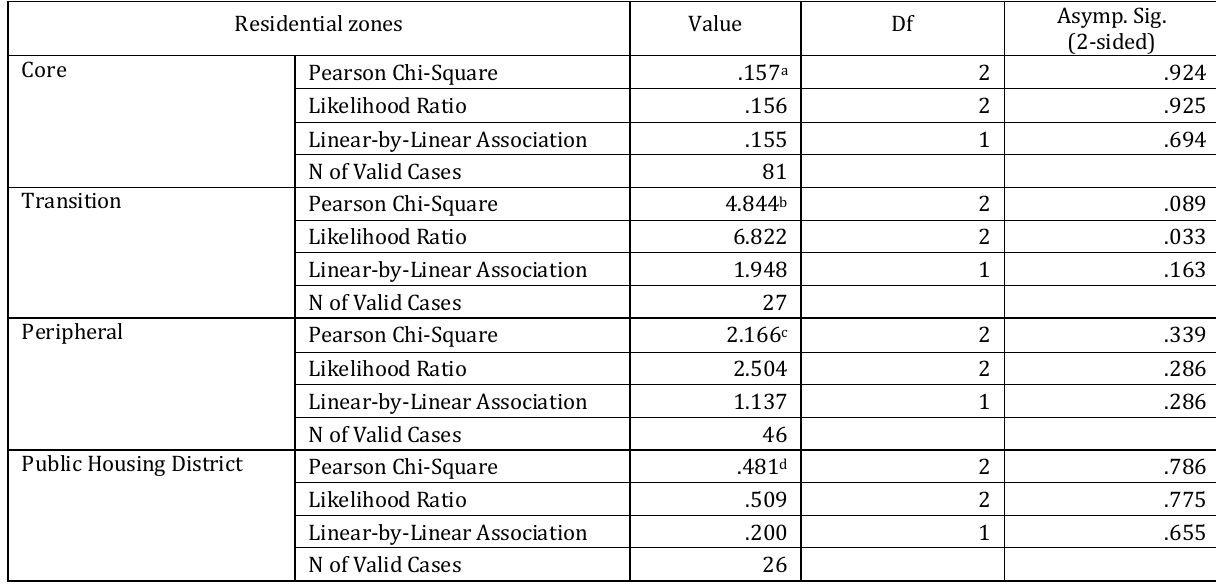
Table 10. Chi-Square summary for providers of waste collection facilities across residential